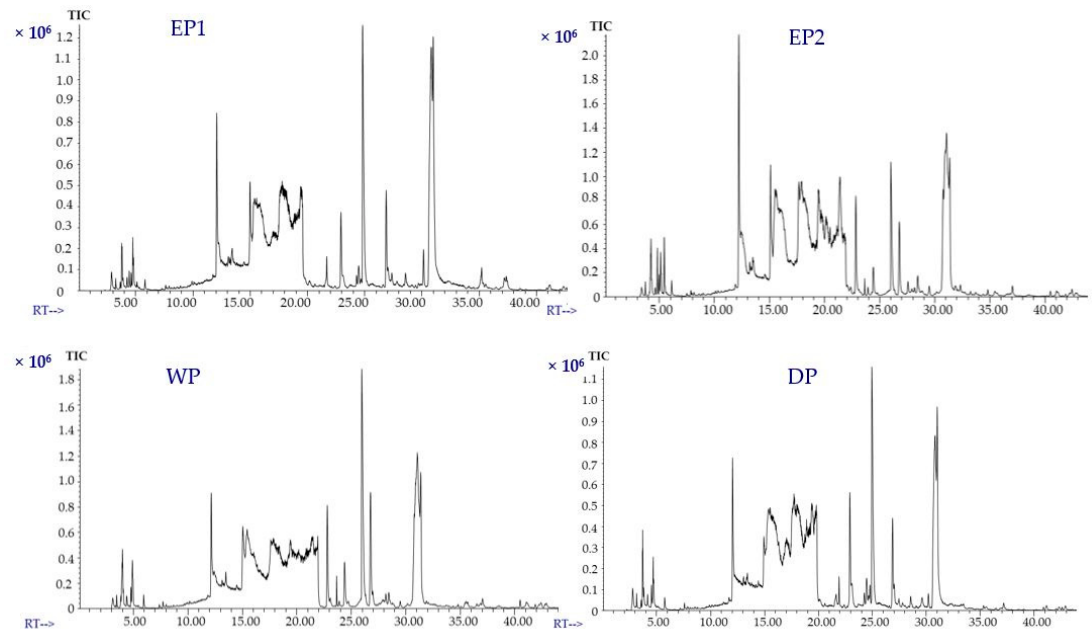
Figure 7. Total ion chromatograms (TICs) of volatile compounds of coffee (brewed samples). (EP1: elephant dung coffee (pulp was completely digested); EP2: elephant dung coffee (pulp was not digested); WP: wet-processed coffee beans; DP: dry-processed coffee beans). RT: Retention time